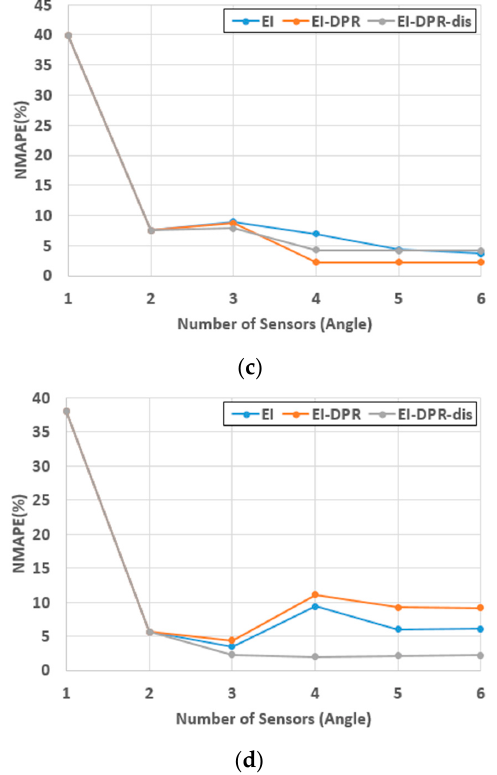
Figure 16. NMAPE by each sensor placement method according to the number of sensors (Case 1: slope only): ( a ) RDS1, ( b ) RDS2, ( c ) RDS3, ( d ) RDS4.